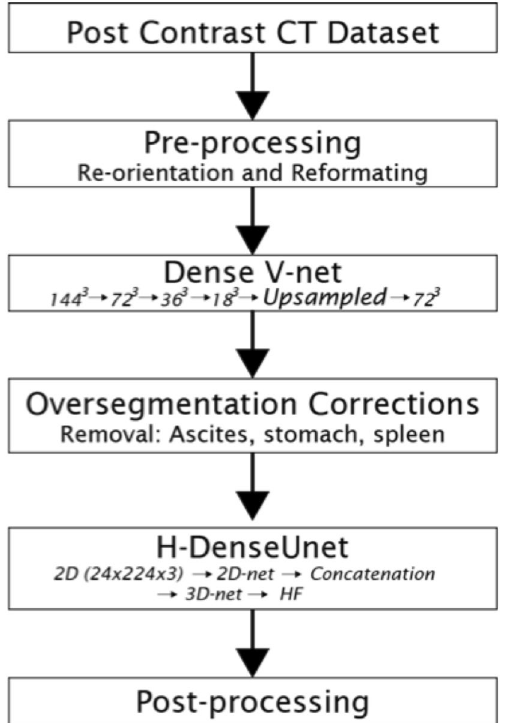
Figure 1. Flowchart schematic outlining the PADLLS steps. First, the imported images are standardized with respect to orientation and format. Next, the V-net segments the study for the initial liver mask (in addition to the stomach and spleen). Oversegmentation correction is then applied though thresholding and finally the H-DenseUnet further refines the liver